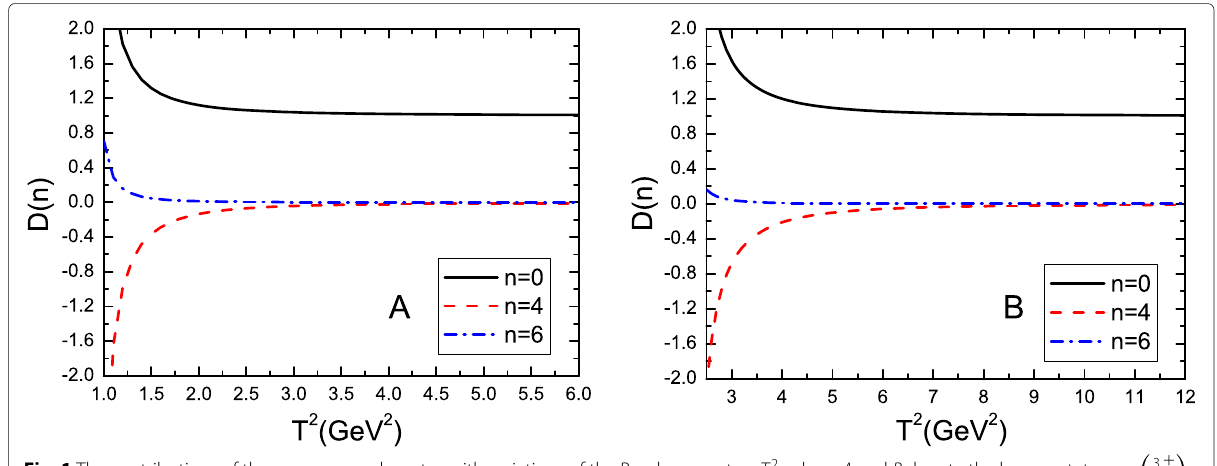
Fig. 1 The contributions of the vacuum condensates with variations of the Borel parameters T 2 , where A and B denote the baryon states ccc 3 + , respectively, n = 0, 4, 6 denotes dimensions of the vacuum and bbb 3 2